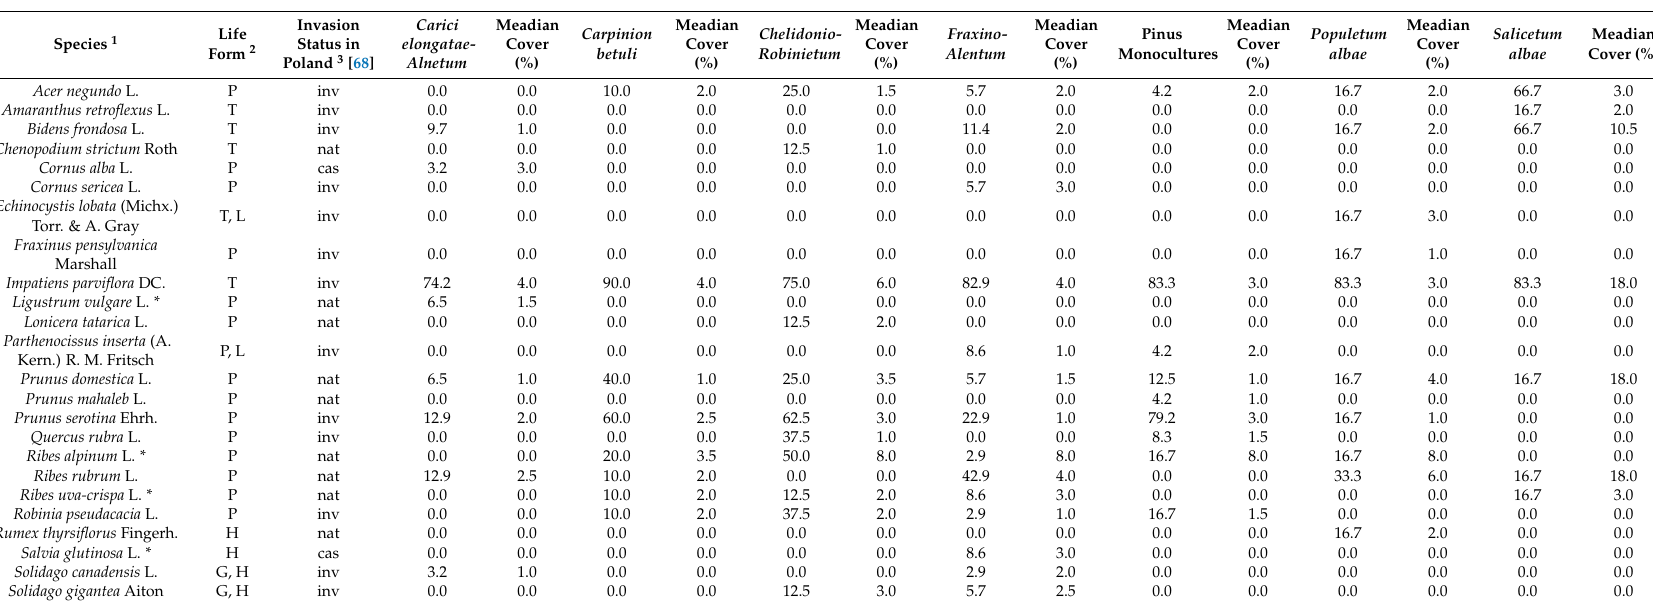
Table 5. Frequency of alien species in the herbaceous layer (% of all plots within each vegetation type) and median cover by vegetation types. Carici Meadian Meadian Meadian Meadian Meadian Invasion Meadian Salicetum Populetum Fraxino- Chelidonio- Carpinion Meadian Pinus elongatae- Cover Cover Cover Cover Cover Status in Cover Species 1 Life Form 2 albae albae Alentum Robinietum betuli Cover (%) Monocultures Alnetum (%) (%) (%) (%) (%) Poland 3 [68] (%) Acer negundo L. P inv 0.0 0.0 T inv 0.0 0.0 0.0 0.0 0.0 0.0 0.0 inv T nat 0.0 0.0 0.0 P cas P inv 0.0 0.0 0.0 0.0 0.0 0.0 0.0 0.0 0.0 0.0 0.0 0.0 Echinocystis lobata (Michx.) Torr. & A. Gray T, L inv 0.0 0.0 0.0 0.0 0.0 0.0 0.0 0.0 0.0 Fraxinus pensylvanica Marshall P inv 0.0 0.0 0.0 0.0 0.0 0.0 0.0 0.0 0.0 0.0 1.0 0.0 0.0 Impatiens parviflora DC. T inv 74.2 P